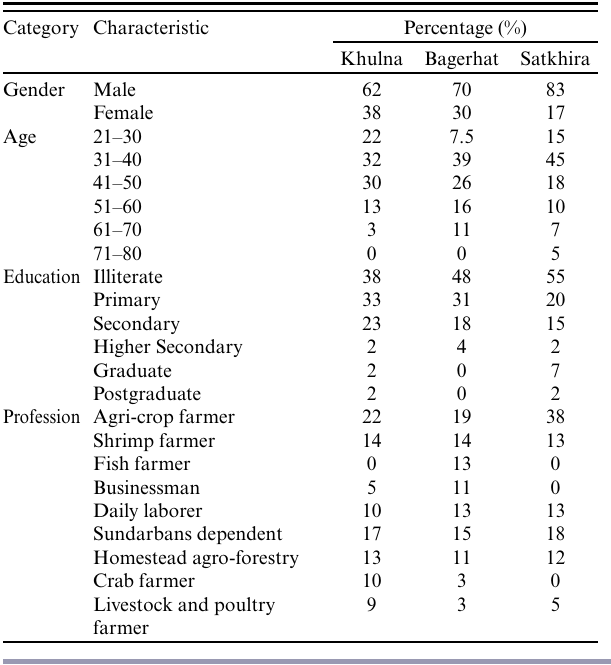
Table 3 . Demographic and socioeconomic status of the household level respondents.